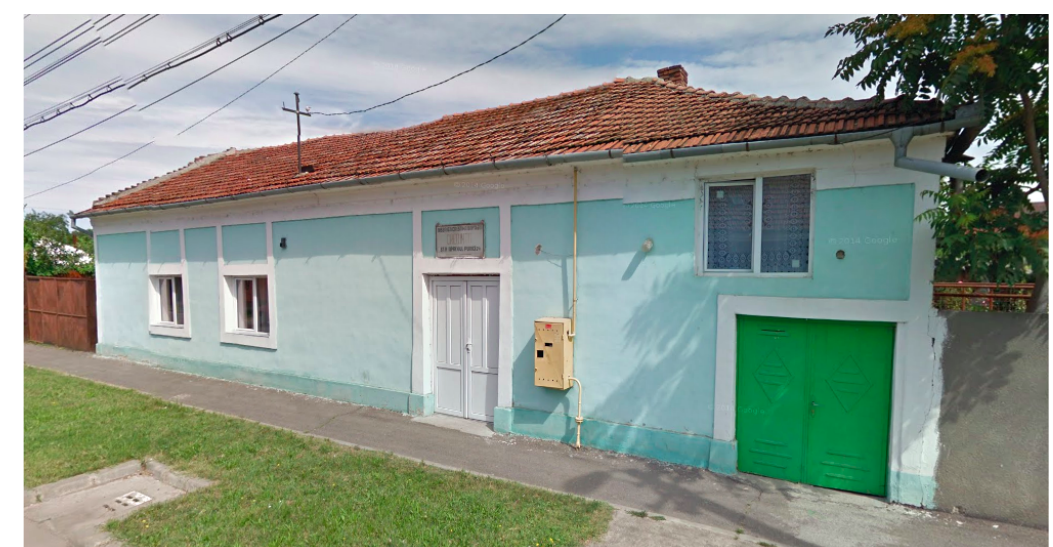
Figure 3. Faith Church in Arad-Sega in 2014. Source: Google